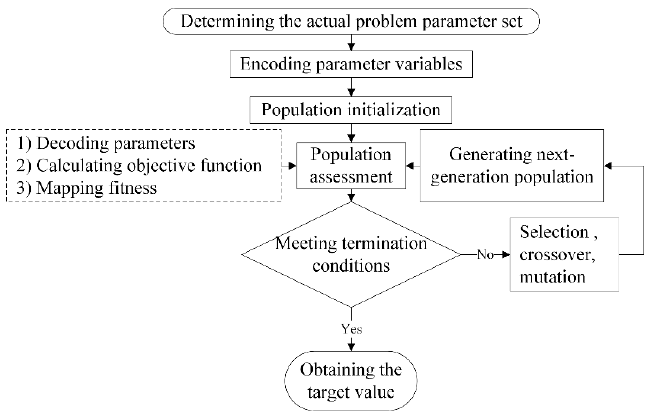
Figure 2. Iteration process of genetic algorithm.